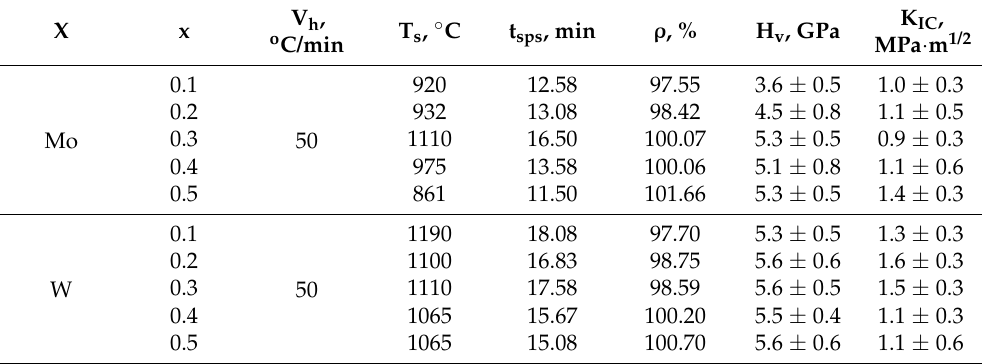
Table 3. Characteristics of ceramic samples of phosphates Na 1-x Zr 2 (PO 4 ) 3-x (XO 4 ) x